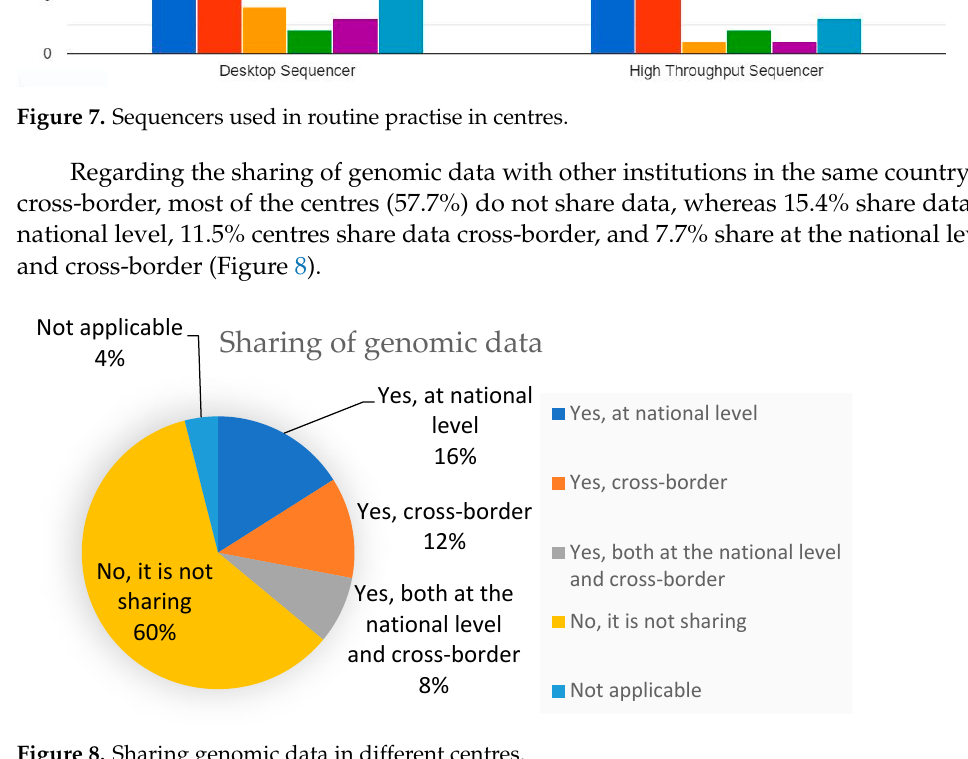
Figure 8. Sharing genomic data in different centres.